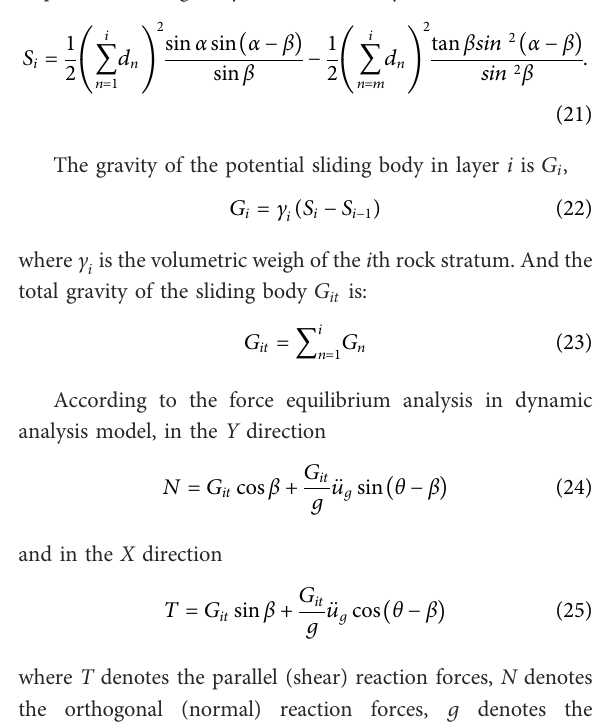
FIGURE 6 Generalized diagram of dynamic model of bedding rock